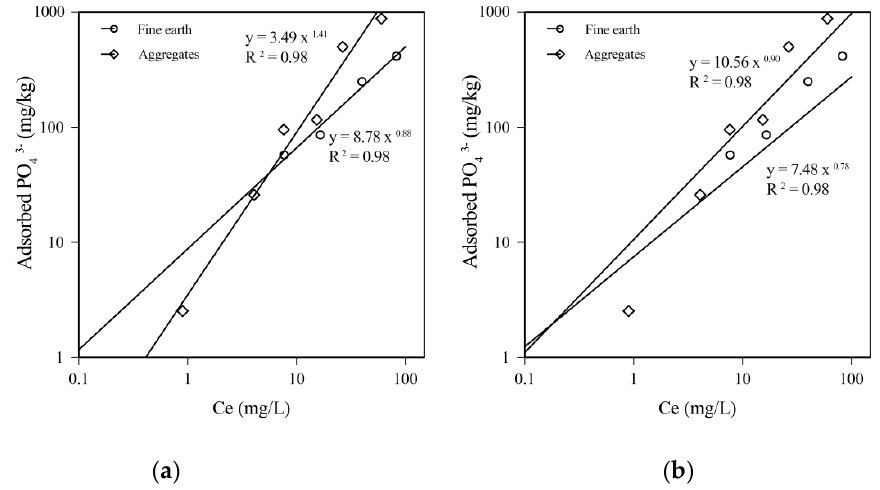
Figure 5. Sorption isotherms of phosphate for samples from ( a ) topsoil and ( b ) subsoil horizons.